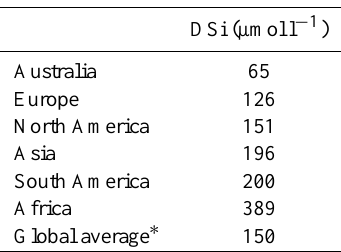
Table 4. The DSi concentration of freshwater at the global scale (modified from Exley, 1998).